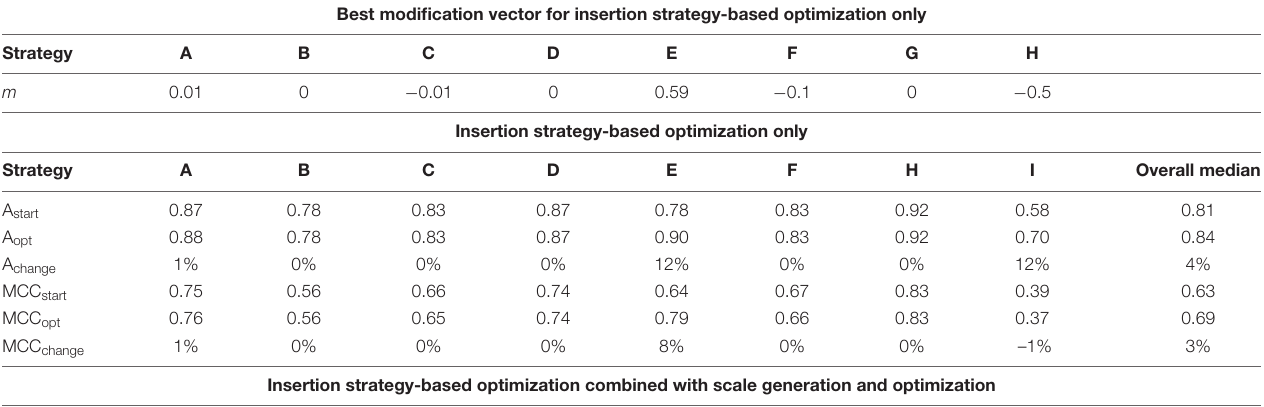
TABLE 1 | Modification vector and summarized model Monte Carlo cross-validation (MC-CV) performance data for the insertion strategy optimization. Best modification vector for insertion strategy-based optimization only